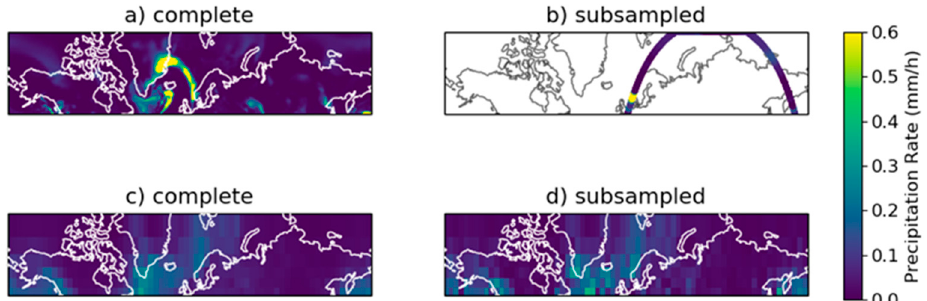
Figure 2. Figure depicting the formation of monthly estimates of global precipitation through complete ( a , c ) and subsampled ( b , d ) CFDDA reanalysis. Subplots ( a , b ) represent a single hour, subplots ( c , d ) represents the average of all hours in a month.